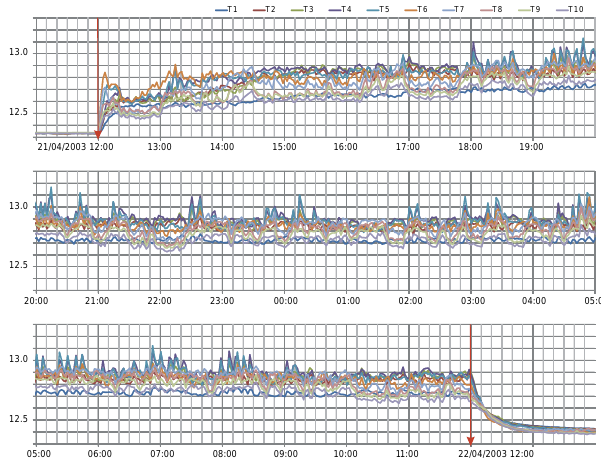
Figure 8. The temperatures in ◦ C at 2m height 1h before, during, Figure 8: The temperatures in C° at 2-meter height 1hour before, during, and 3 hours after the A6a experiment. T1, T2, and 3h after the A6a experiment. T1–T10 denote temperature series … , T10 denote temperature series of the ten sensors on the AIII set-up. of the 10 sensors on the AIII setup.